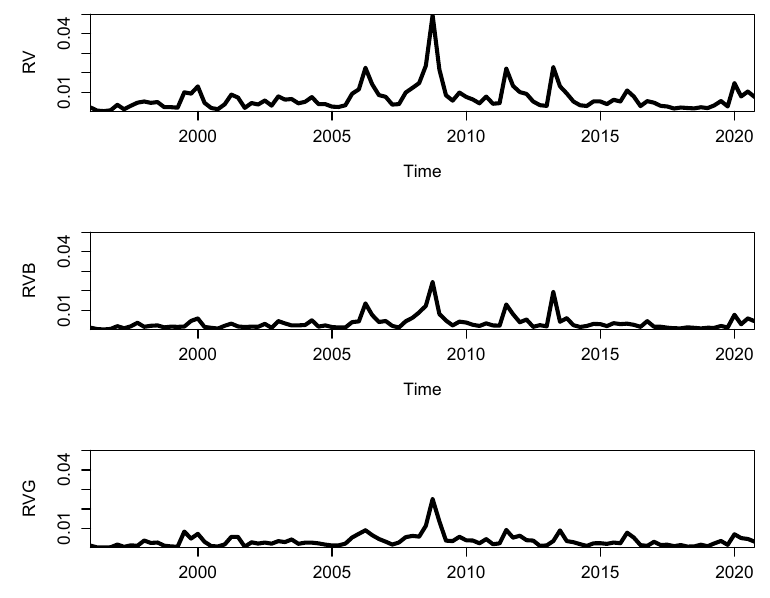
Figure 1. The Data. Note: RV: Realized variance. RVB: Downside (“bad”) realized variance. RVG: Upside (“good”) realized variance.